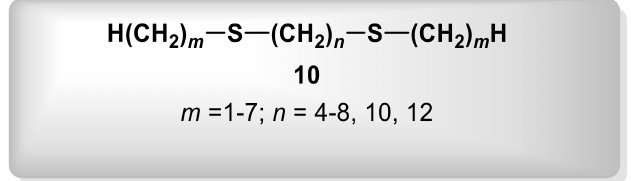
Figure 4. Structures of dithiaalkanes 10 used in the